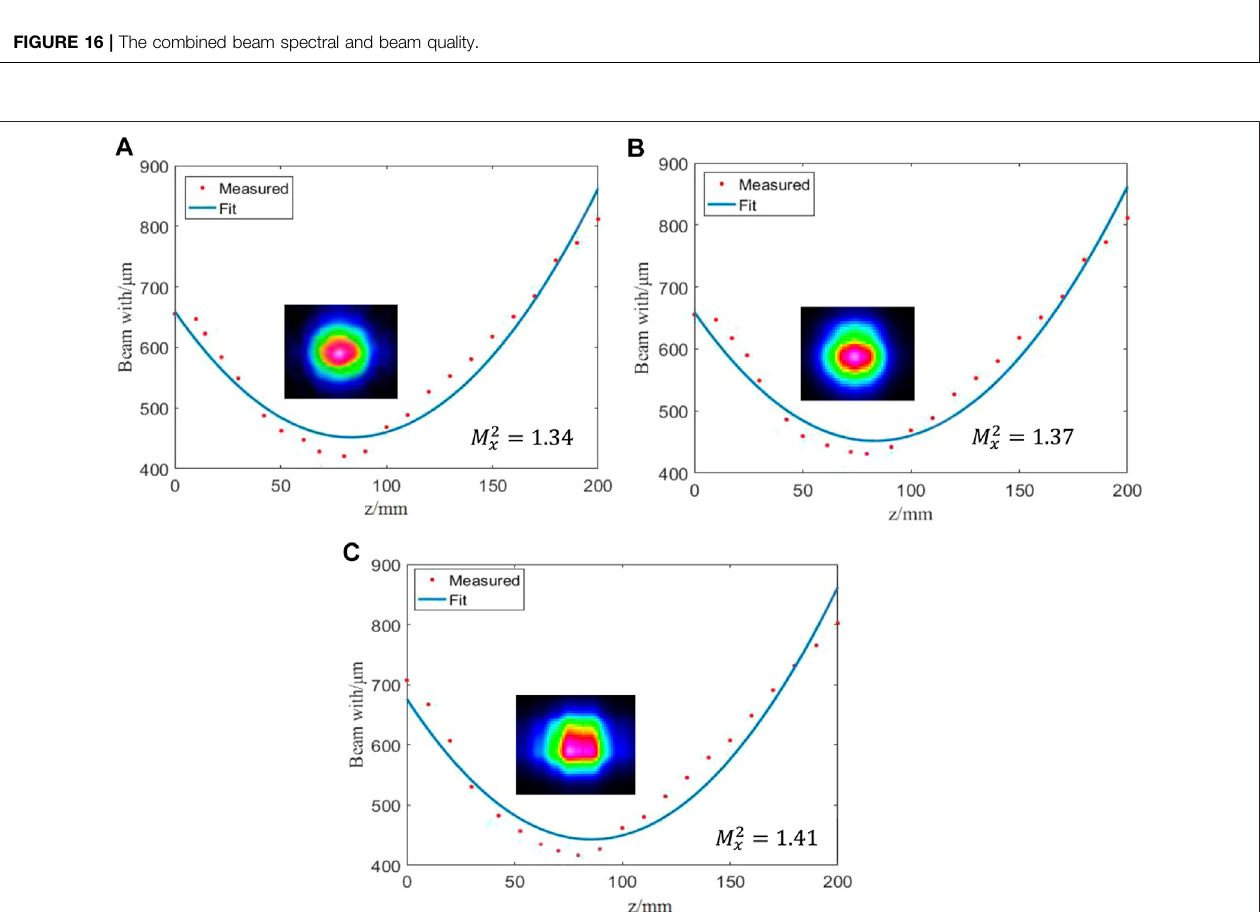
FIGURE 17 | Measured beam pro fi le and quality factor: (A) 30, (B) 60, and (C) 120 s.